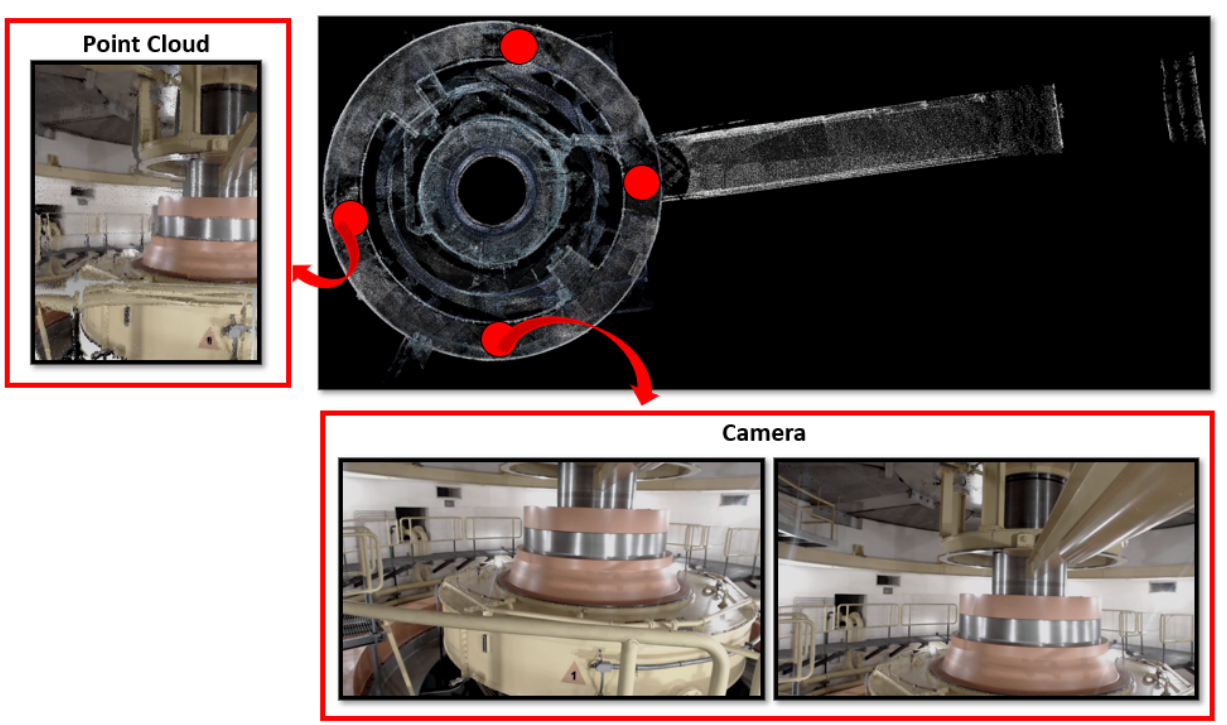
Figure 8. Turbine room, scanned by 4 robots. The top view is presented, with the red dots indicating the robots positions. Point cloud and camera views are